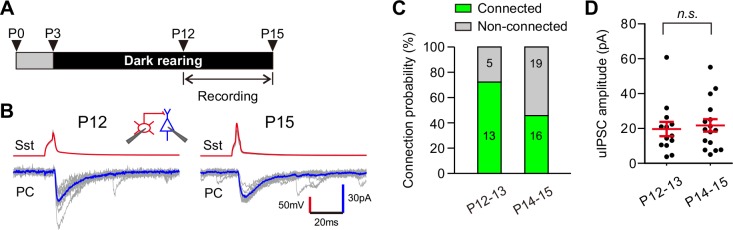
Dark rearing prevents the developmental decrease of synaptic transmission from Sst-INs to PCs.(A) Schematic schedule of dark rearing and electrophysiological recording. (B) Representative evoked responses from an Sst-IN to a PC at P12 and P15 in dark-reared mice. Insert, schematic of paired recording of an Sst-IN (red) and a PC (blue). (C) The occurrence of connection from Sst-INs to PCs in dark-reared mice was not significantly different between P12–13 and P14–15. (D) The peak amplitude of uIPSCs did not change significantly from P12–13 to P14–15 in dark-reared mice. Detailed statistical analysis, detailed data, and exact sample numbers are presented in Figure 6—source data 1. n.s., p>0.05.